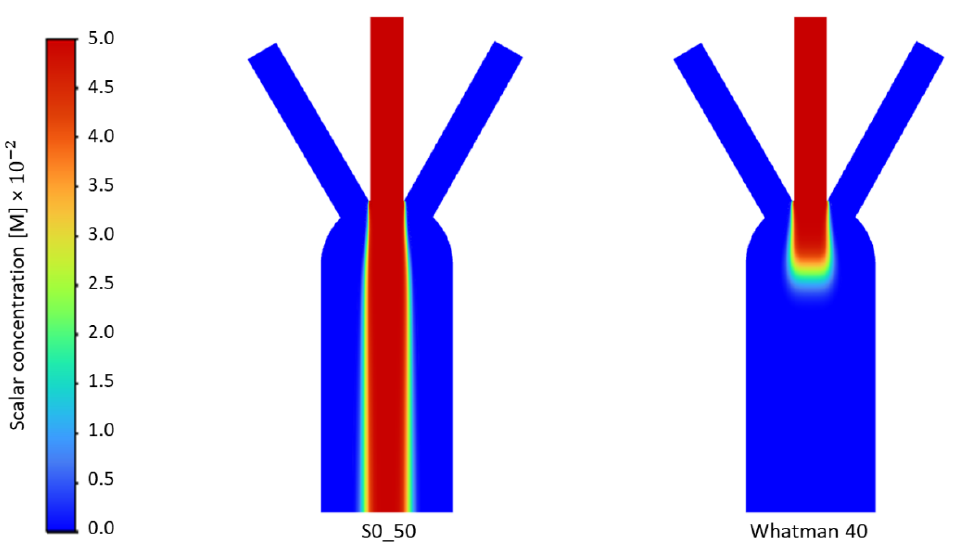
Figure 5. Diffusion contours of Sisal (0_50) and Whatman 40 for time transient simulation.